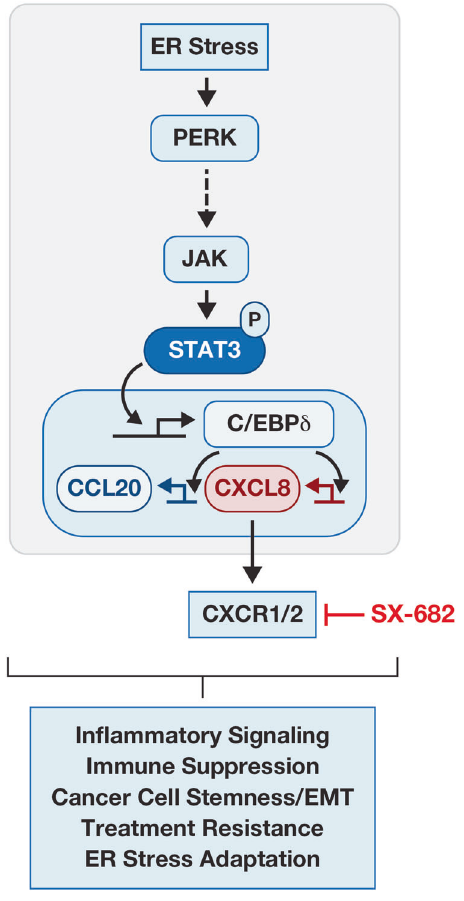
Fig. 8 Model summarizing the pathway described in this study along with known effects of CCL20 and CXCL8 signaling in the context of cancer. Some of the relationships in this linear pathway may be the result of indirect mechanisms (indicated by dotted line) and/or also include the contribution of additional co-factors (not